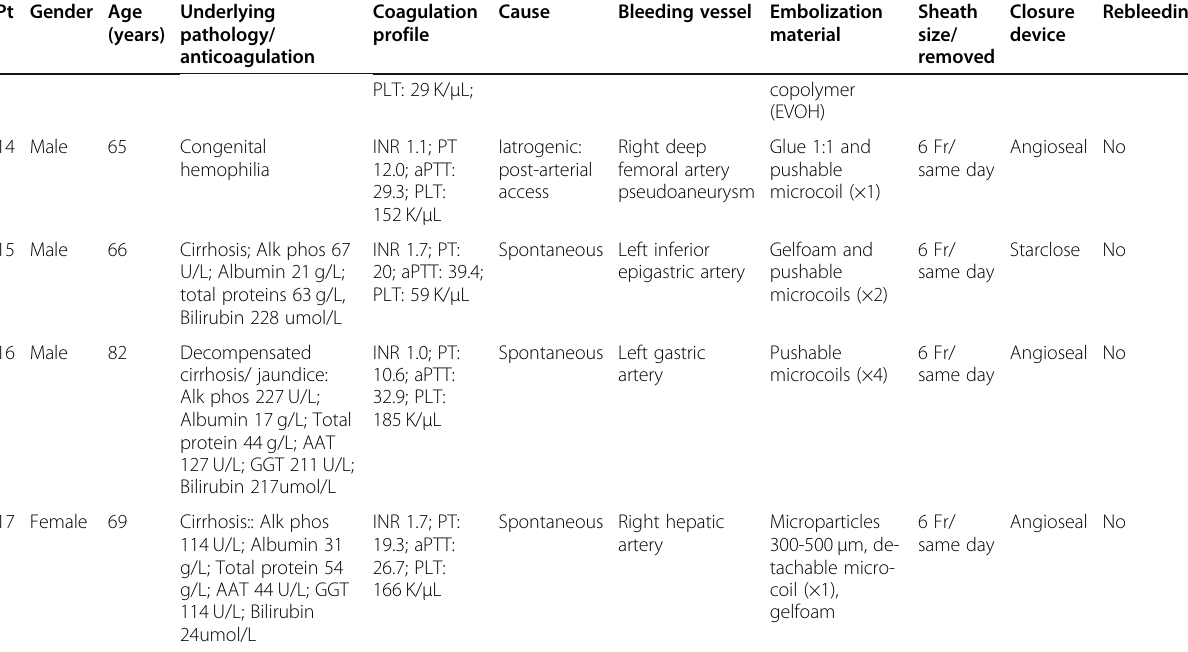
Table 1 Demographical data, coagulation data and procedural details (Continued) Pt Gender Age Underlying (years) pathology/